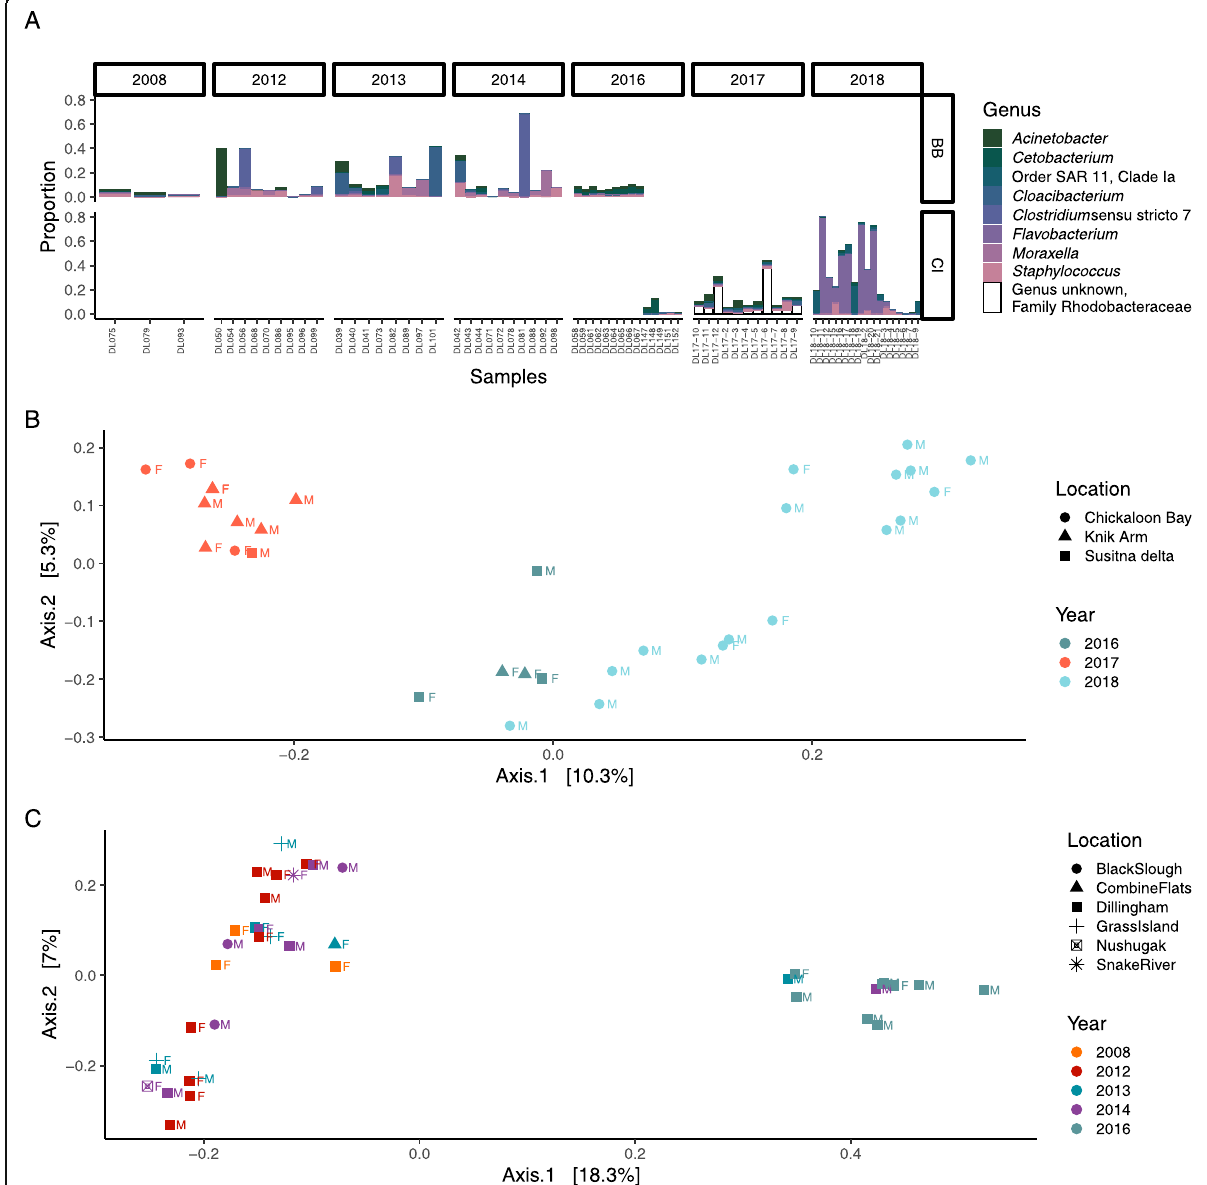
Fig. 3 Annual variability within each regional population. a Variation in proportional abundance of top 20 ASVs associated with individual whales in Bristol Bay (top row) and Cook Inlet (bottom row), organized by genus. Each bar represents an individual sample, grouped by year along the x- axis. The bottom two plots are PCoA analyses based on Bray-Curtis dissimilarity comparison of epidermal microbiota, with color by year, shape by sampling location, and label by sex, in b Bristol Bay and c Cook